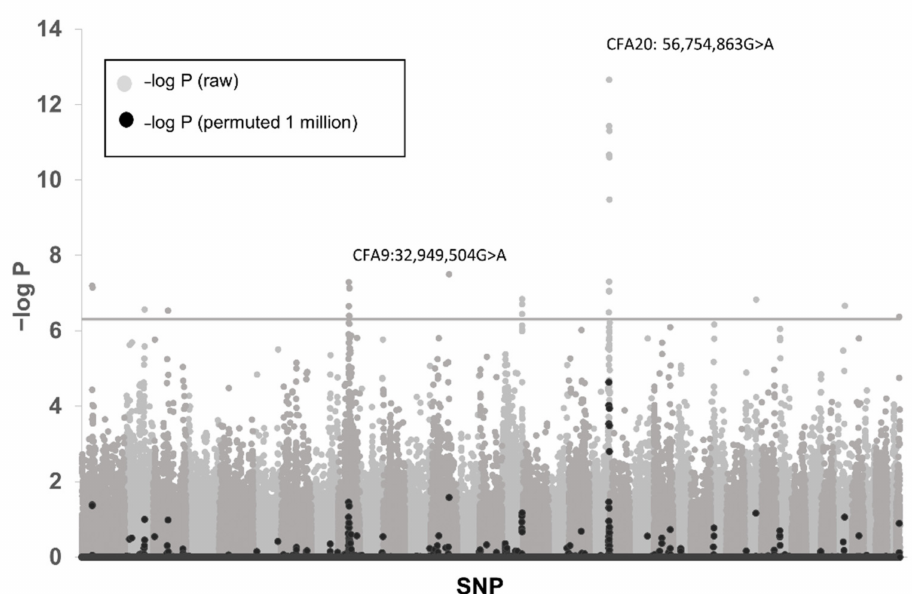
Figure 1. Manhattan plot of genome-wide association with 45 CA affected kelpies and 290 controls. Negative log of raw CHI-squared probabilities is shown in grey, and permuted (1 million permuta- tions) values are shown in black. The most significant associations were identified on CFA20 and CFA9 corresponding with two different disease phenotypes in the data. The notional cut-off for significance (P raw ) is indicated by a grey line ( − log P = 6.3).